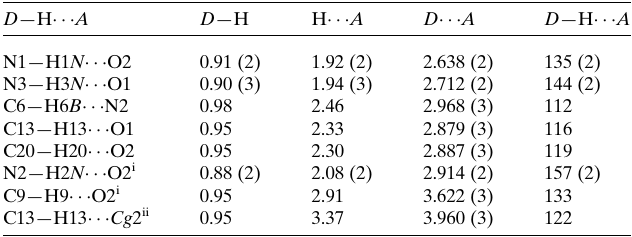
Table 5 Hydrogen-bond geometry (A˚ , (cid:3) ) for ( II ).